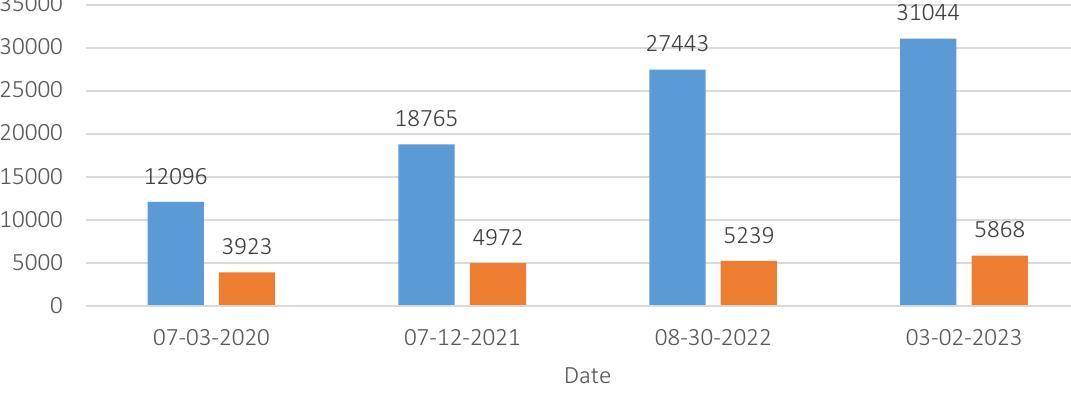
Figure 3. The number of educational materials and navigators of educational resources in the JetIQ